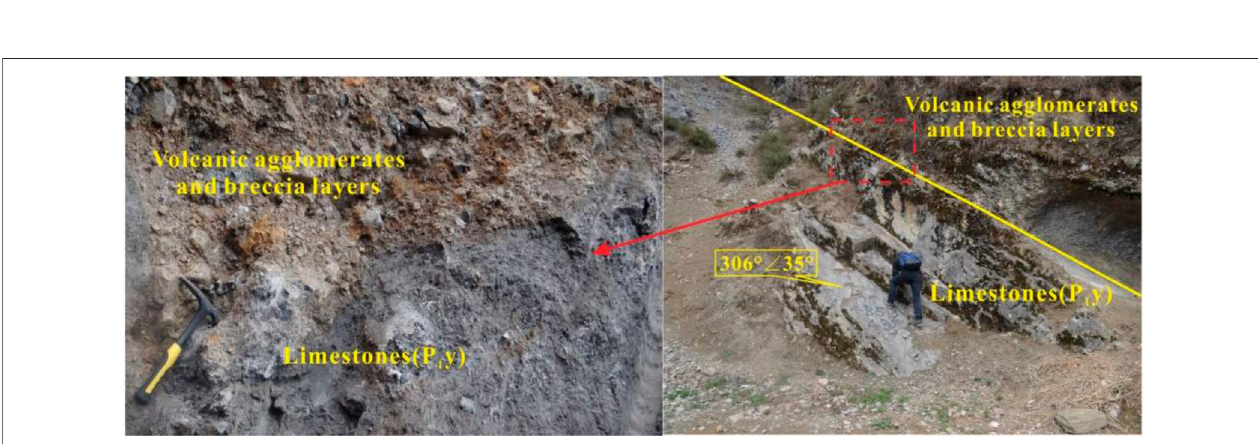
FIGURE 11 | The weak intercalation of volcanic agglomerates and breccias form the contact surface between basalt and underlying limestone (the photographing orientation is 340 ° ).